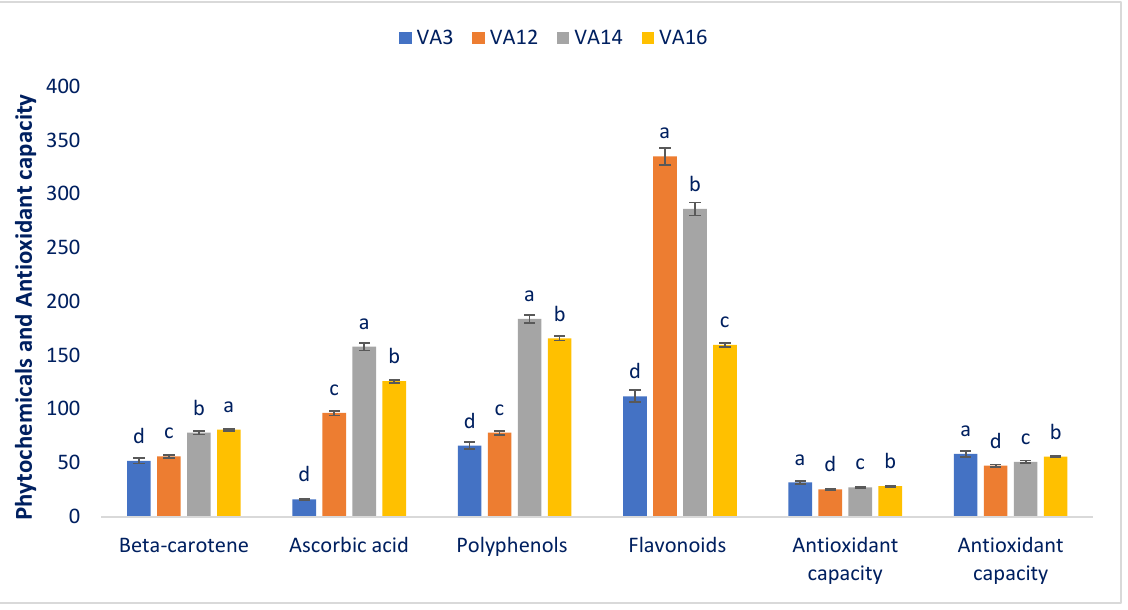
Figure 5. Contents of bioactive phytochemicals and free-radical scavenging capacities of drought- resistant amaranth (beta-carotene (mg 100 g − 1 FW); ascorbic acid (mg 100 g − 1 FW); polyphenols ( µ g GAE g − 1 FW); flavonoids ( µ g RE g − 1 DW); AC (DPPH), antioxidant capacity (DPPH) ( µ g TEAC g − 1 DW); AC (ABTS + ), antioxidant capacity (ABTS + ) ( µ g TEAC g − 1 DW)). Dissimilar letters indicate statistical significance according to DMRT ( p < 0.01), ( n =